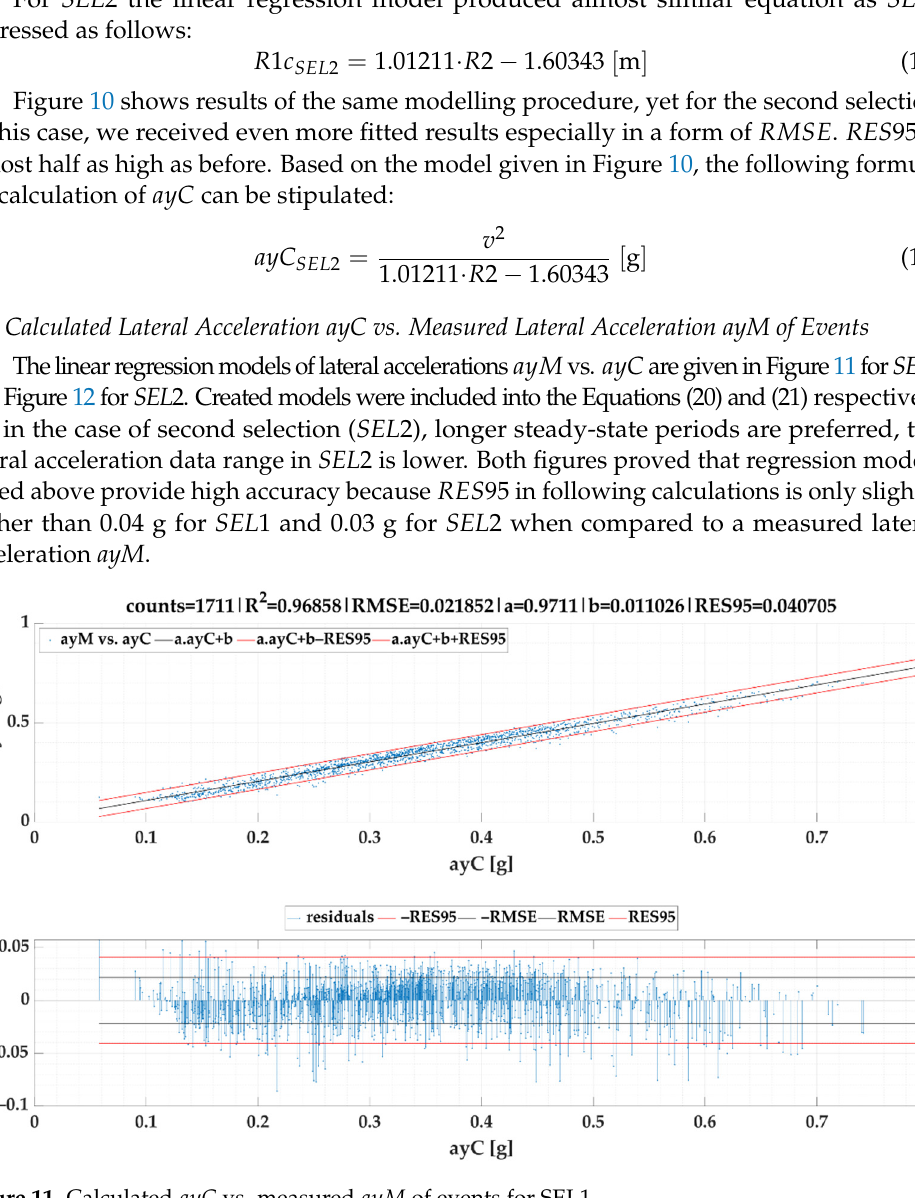
Figure 11. Calculated 𝑎𝑦𝐶 vs. measured 𝑎𝑦𝑀 of events for SEL1.